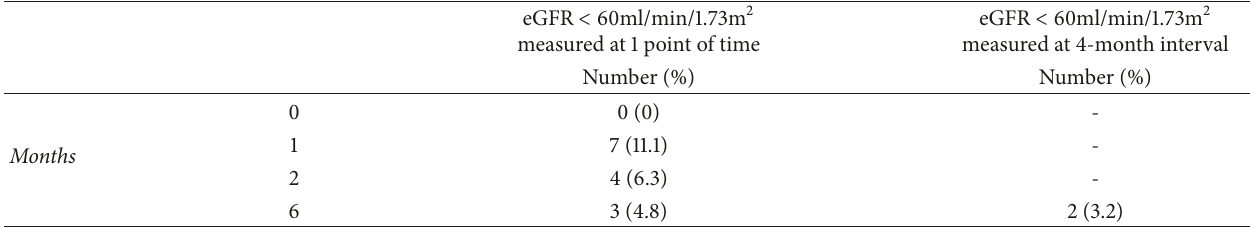
Table 4: Chronic kidney disease among study participants in TASH, October 2017 [n = 63].